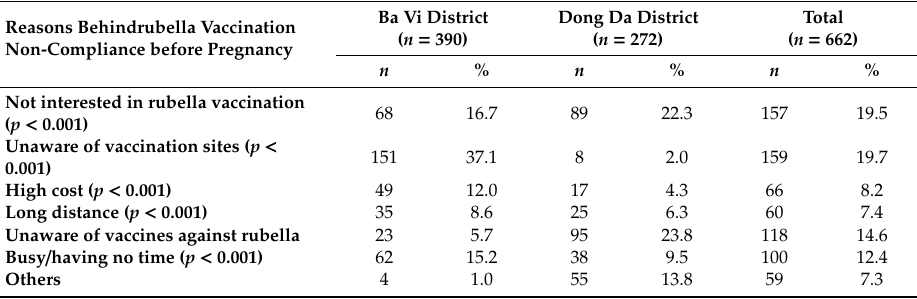
Table 3. Reasons behind non-compliancewith rubella vaccination before